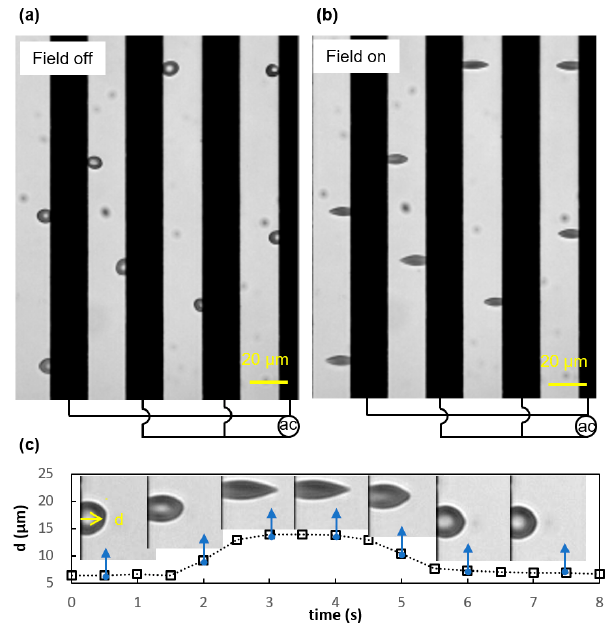
Figure 2. Experimental observations of electrodeformation of erythrocyte membranes in interdigitated electrode settings. ( a ) Cells are freely suspended in the medium when the electric field is off. ( b ) Cells are stretched by the DEP force when the electric field is supplied. ( c ) Representative electrodeformation of the cell membrane, d , as quantified by the maximum displacement of the cell membrane to the edge of the electrode. Insets show representative deformation of the cell membranes with time.